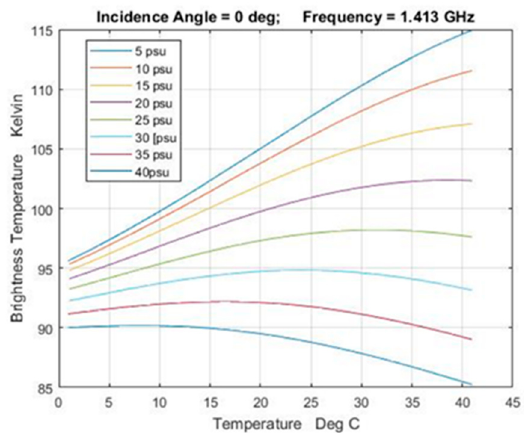
Figure 2. Brightness temperature as a function of SST for constant SSS. The calculations are for a flat surface (no wind), a frequency of 1.413 GHz and at nadir (zero incidence angle). The calculations use the Klein-Swift dielectric constant model function [19].